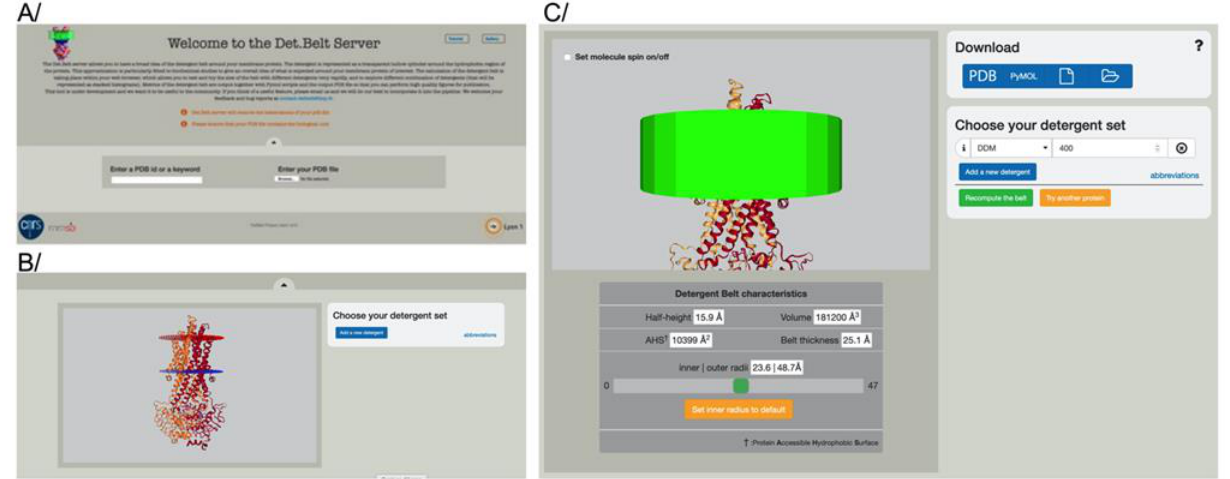
Figure 1. Det.Belt web interface. ( A ) Home page where investigators can either search for a pre-oriented membrane protein structure using PDB identifiers or keywords, or provide their own oriented structure file. ( B ) Display of the oriented protein. The red and blue spheres represent the extracellular and cytoplasmic sides of the membrane, respectively. Each chain is shown as a cartoon in a different color. ( C ) Typical output from Det.Belt shown here with the DDM belt displayed in green. PDB code used in this figure: 2hyd.